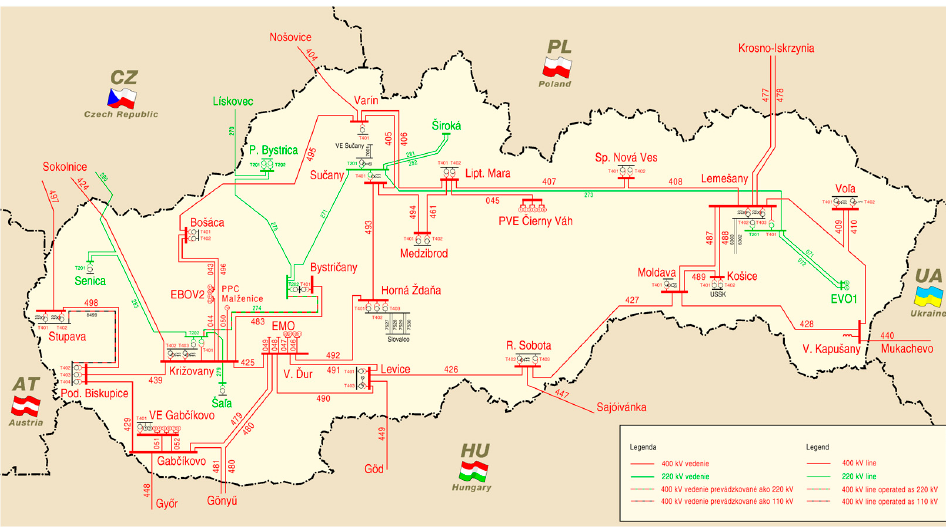
Figure 2. Grid map of the power system of The Slovak Republic for the state of 2021 [18]. Furthermore, the Slovak Republic was divided into three distribution companies, namely West Slovak Distribution, a.s. (ZSD), Middle Slovak Distribution, a.s. (SSD), and East Slovak Distribution, a.s. (VSD). As shown in Figure 3.